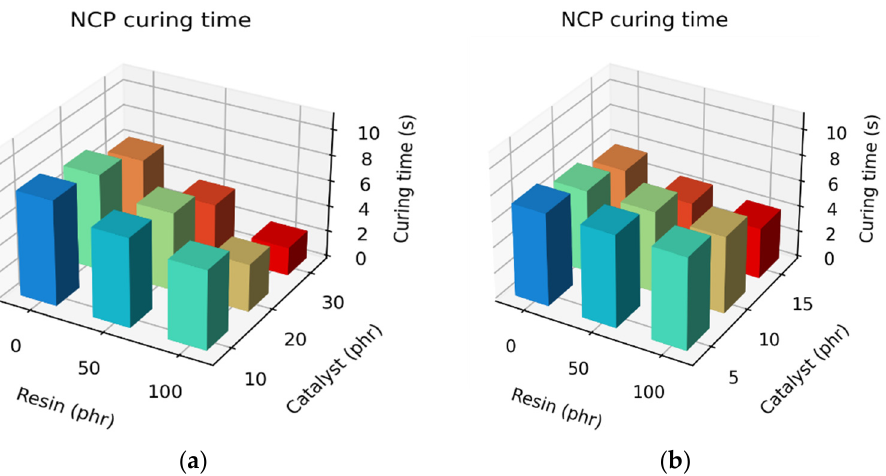
Figure 6. The predicted curing time with DGEBA (resin) ( a ) with HX-3941 (catalyst) and ( b ) with 2MZ (catalyst).